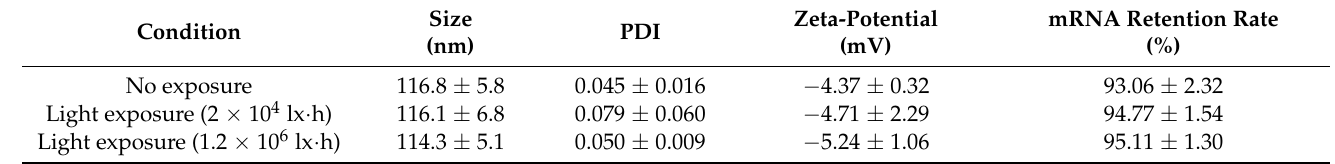
Table 5. Effects of the light exposure on particle properties of the mRNA encapsulating LNPs.